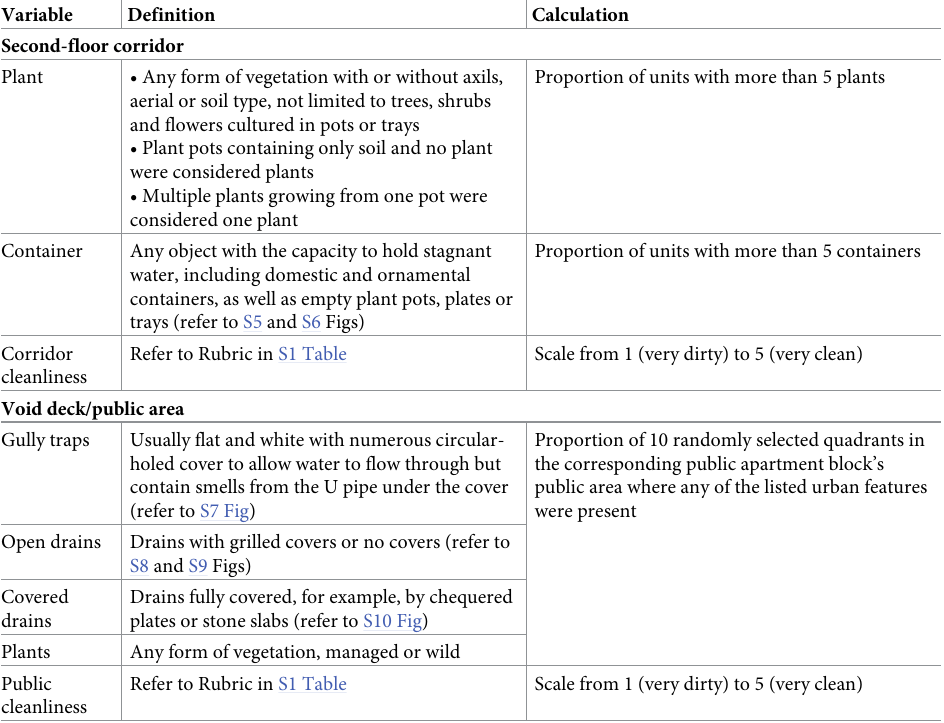
Table 1. Definitions and parameters of variables